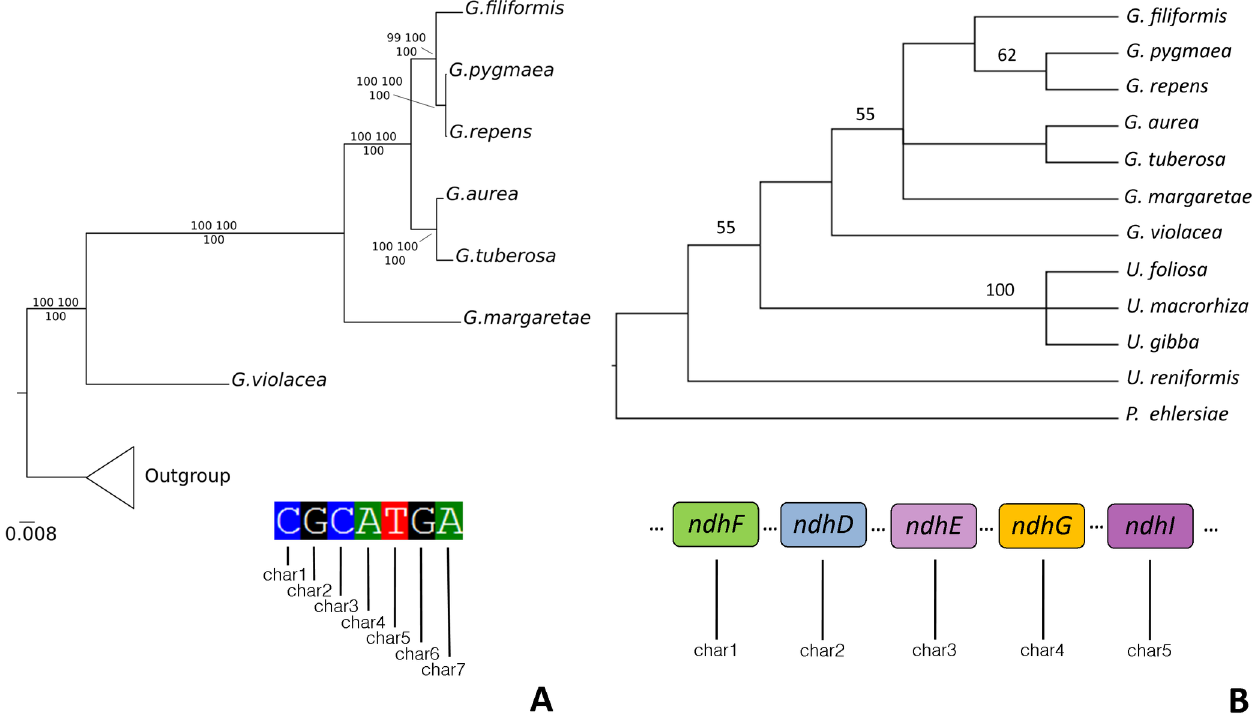
Fig 5. Phylogenetic hypothesis based on ndh sequences. A. Analysesbased on ndh sites (nucleotide-by-nucleotide). In this analysis, each nucleotidewas used as one character (e.g. char1, char2, char3) B . Strict consensusof the two most parsimonioustrees (33 steps; IC = 0.70; IR = 0.78) based on the matrix codifiedfor ndh patterns. In this analysis, each ndh gene was appliedto two characters: one codified as absent (state 0) or present (state 1) (characters 1 to 11) and other codified as pseudogenized(state 0), decayed(state 1), complete (state 2) and inapplicable(state “-”, when the gene is deleted) (characters 12 to 22). For details see S2, S3 and S4 Tables.